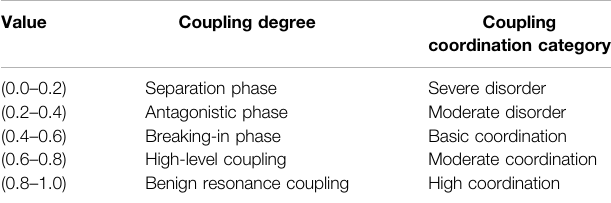
TABLE 4 | Classi fi cation standards of the coupling degree and coupling coordination